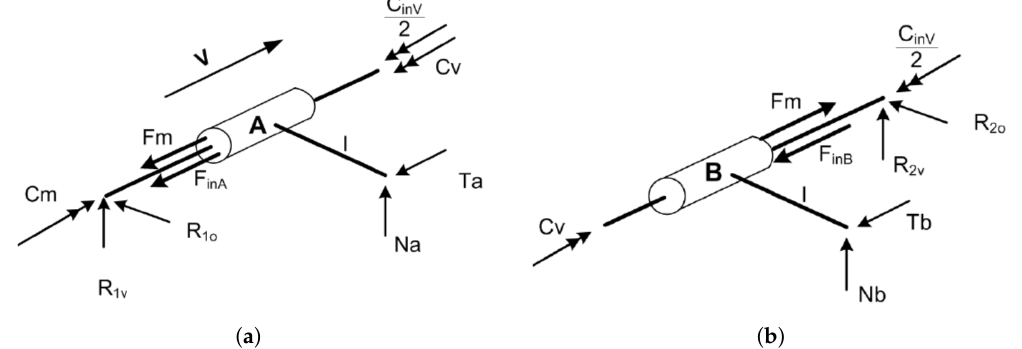
Figure 6. Force schemes for normal reactions at sliders. ( a ) Subsystem A. ( b ) Subsystem